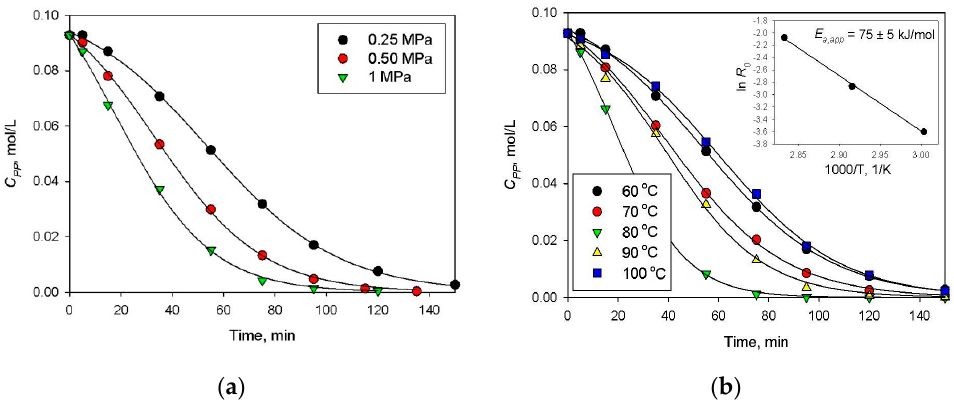
Figure 13. Effect of overall pressure ( a ) and temperature ( b ) on selective hydrogenation of PP to PPL using 1wt.% Pd/HPS-NR 2 ( C PP ,0 = 0.09 mol/L, catalyst loading 100 mg).